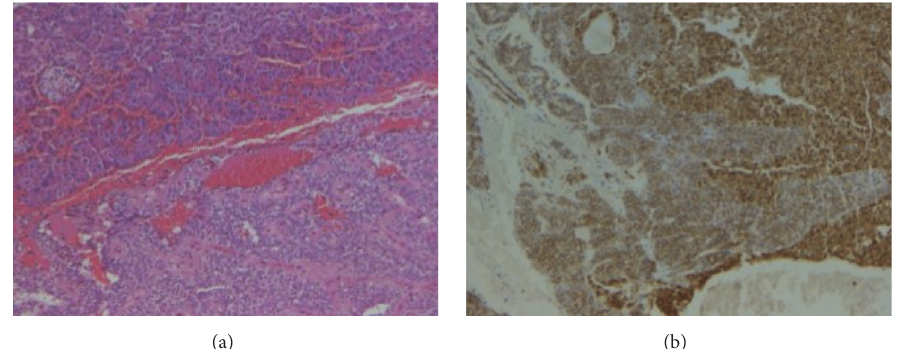
Figure 3: Hematoxylin and eosin stain (H&E, 100x) of SPT showing normal pancreas on the upper left side and neoplastic cells in the lower right side (a) and immunohistochemical 𝛽 -catenin slide (100x) showing the different pattern of staining in normal pancreas (cytoplasmic) and in neoplastic pancreas (nuclear) (b).